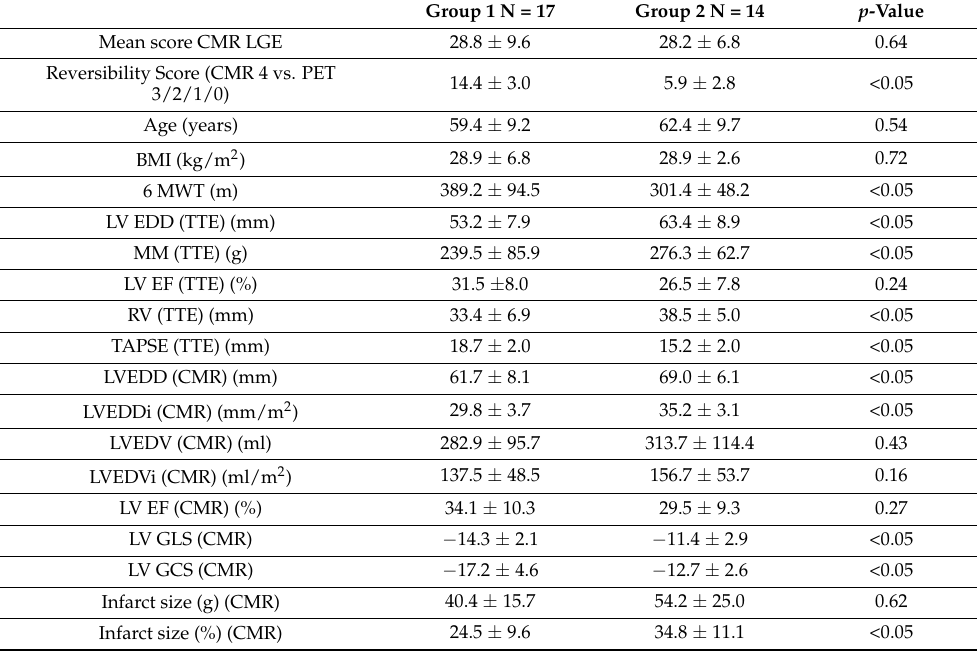
Table 3. Comparison of two groups (1 group—viable myocardium, reversibility score > 10; 2 group— non-viable myocardium, reversibility score ≤ 10).